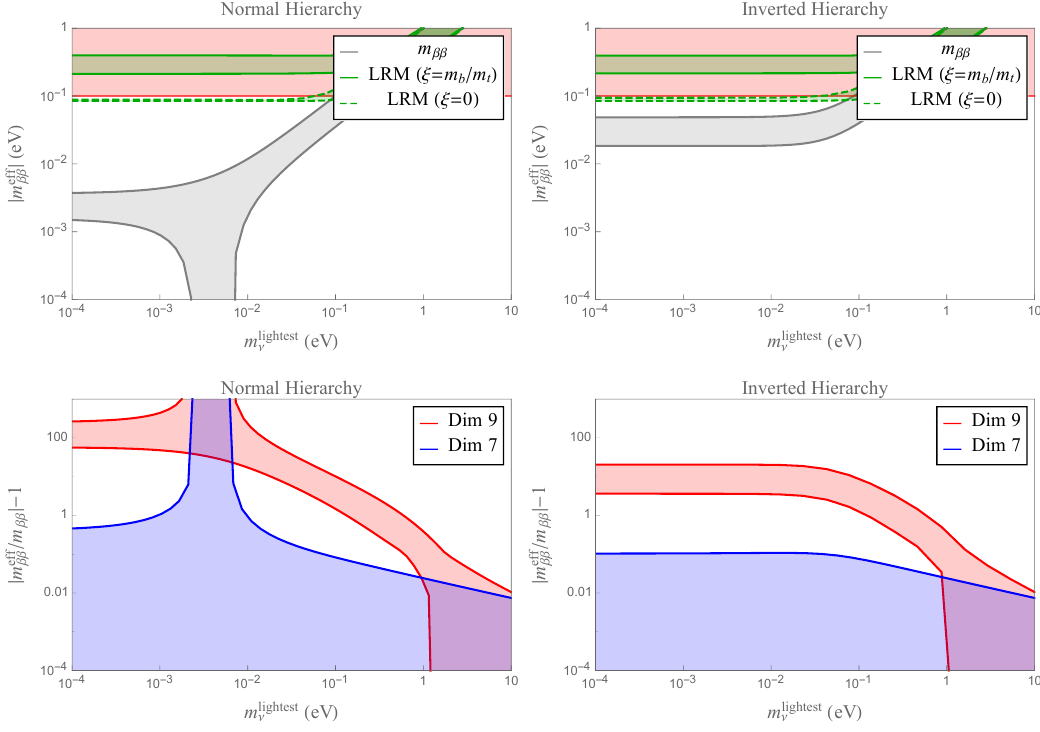
Figure 5 . Same as (cid:12)gure 3, now with the choice of the model parameters in eq.